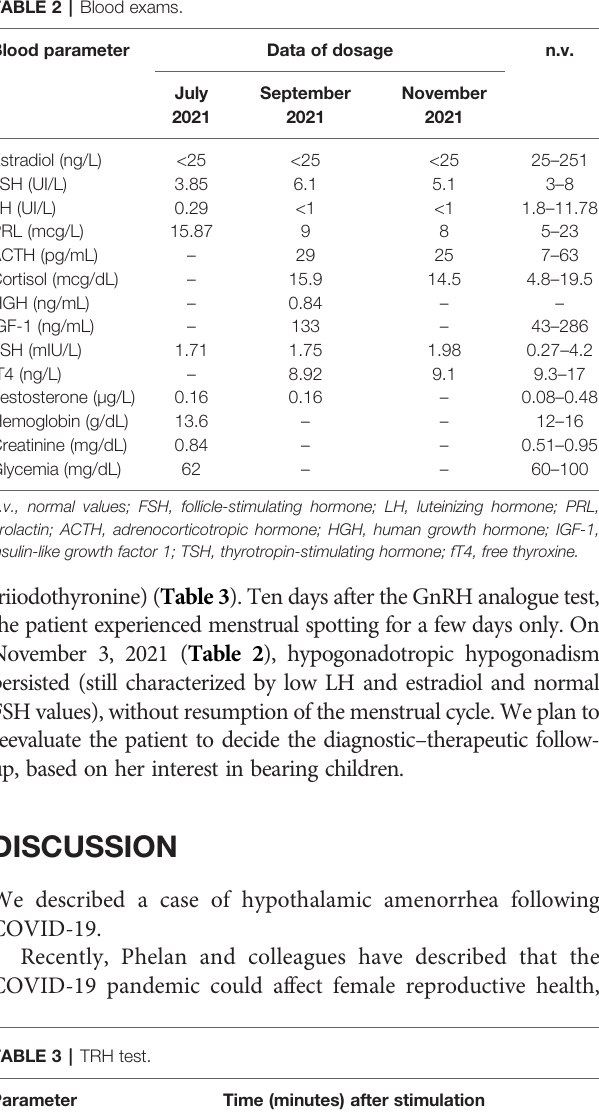
TABLE 2 | Blood exams.